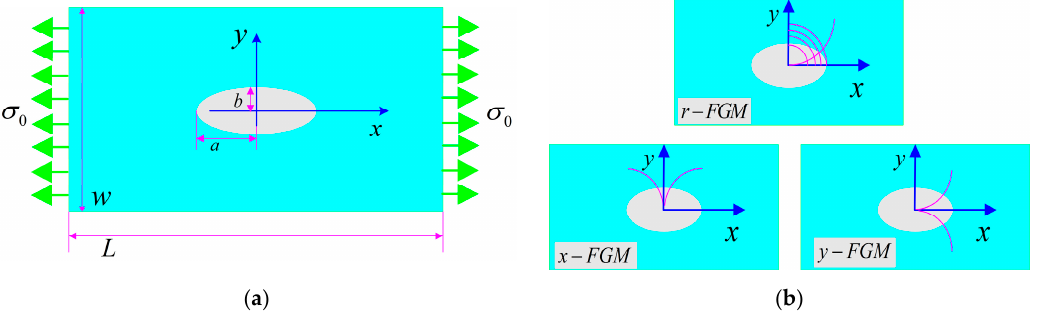
Figure 1. Schematic sketch of boundary value problem ( a ) a rectangle panel with an elliptical hole subjected to a uniform tensile traction; ( b ) three different gradient directions. The origin of the Cartesian and polar coordinates coincides with the center of the elliptical hole. In the case of the r-, x- and y-FGM symmetric property variations are shown.